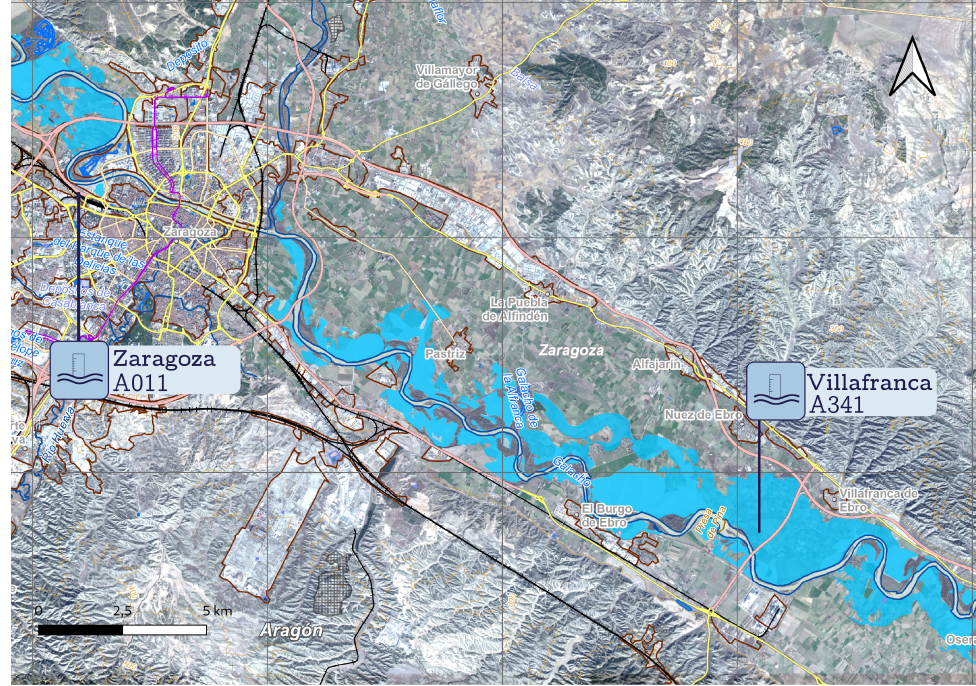
Figure 3. Zoom view of an ortophoto with measured extension of the flooded area (blue) in 2018 flood